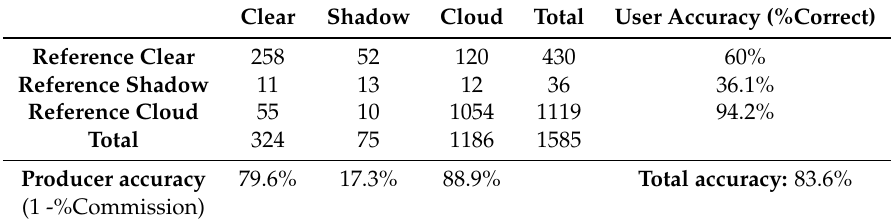
Table 3. Cross-tabulation between visually interpreted reference classes (from 1585 visual samples) and output classes from automatic cloud and shadow detection.